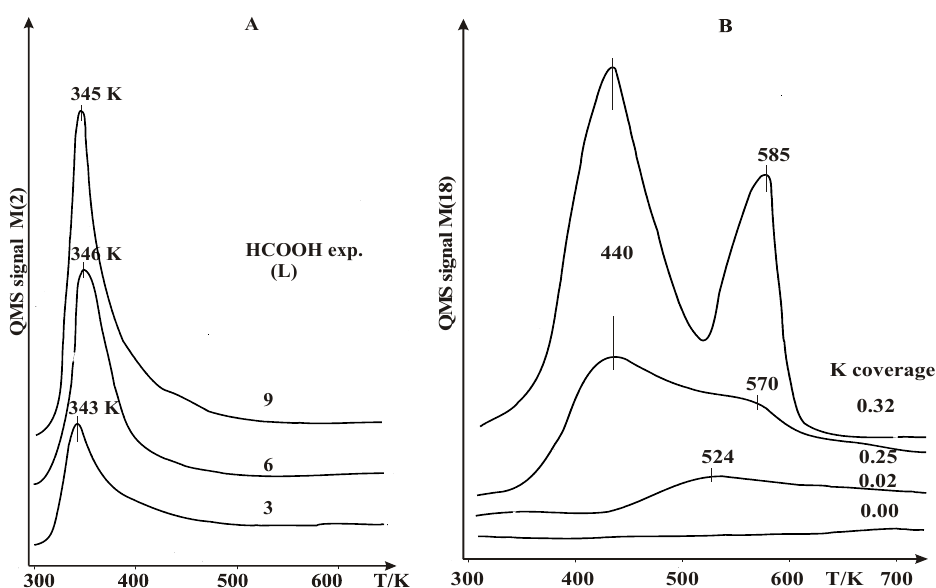
Figure 2. ( A ) Thermal desorption spectra of H 2 from monolayer potassium coverage, ( Θ K = 0.3). ( B ) Thermal desorption spectra of H 2 O from di ff erent potassium covered Rh(111). The CO 2 TD spectra, after adsorption of FA at 300 K, are more complex, due to the desorption and di ff erent steps of decomposition of surface complexes. Significant di ff erences can be seen at di ff erent potassium coverages. TDS for CO 2 at Θ K = 0.1 are displayed in Figure 3A.